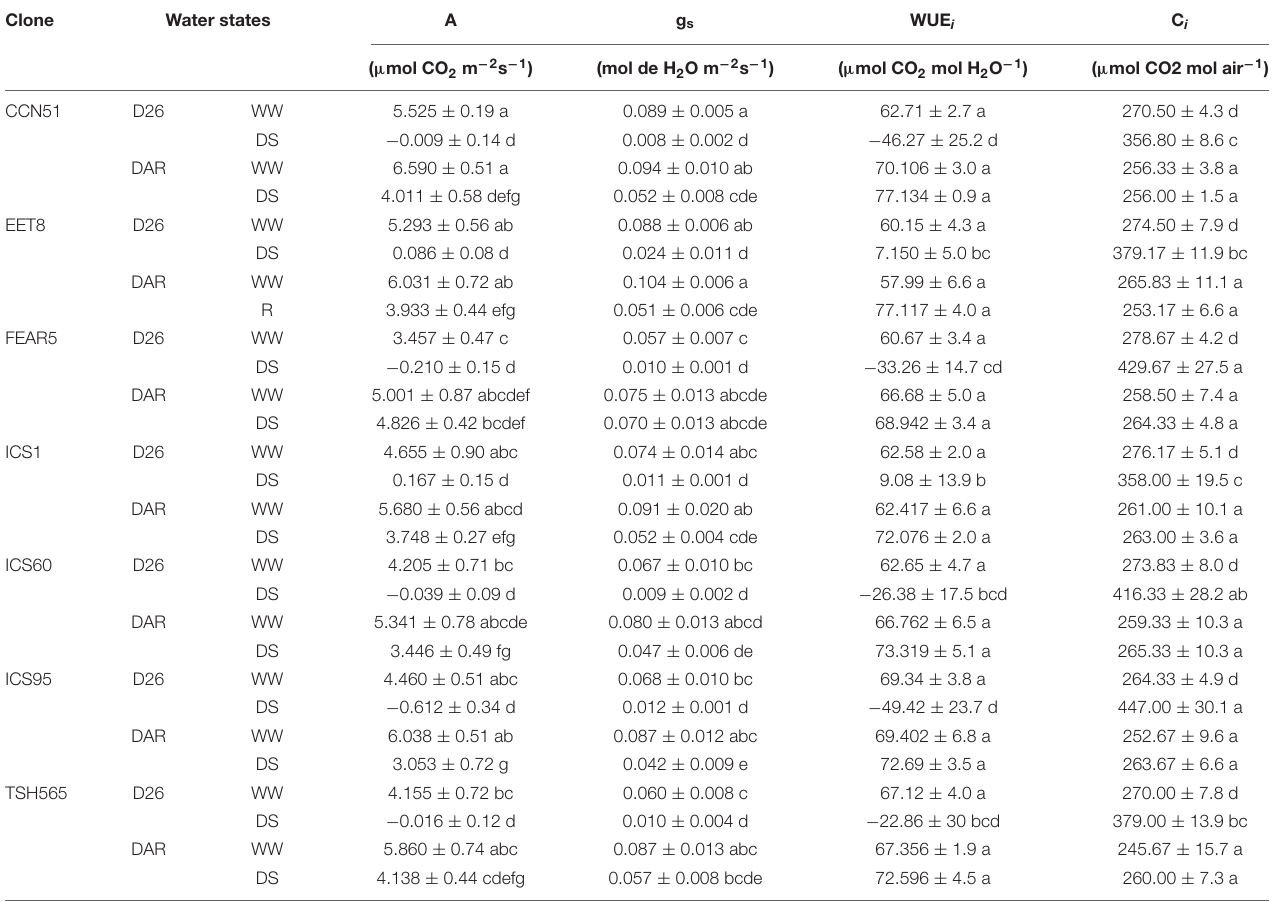
TABLE 5 | Changes in gas exchange parameters of the seven cacao clones under different water states. Clone Water